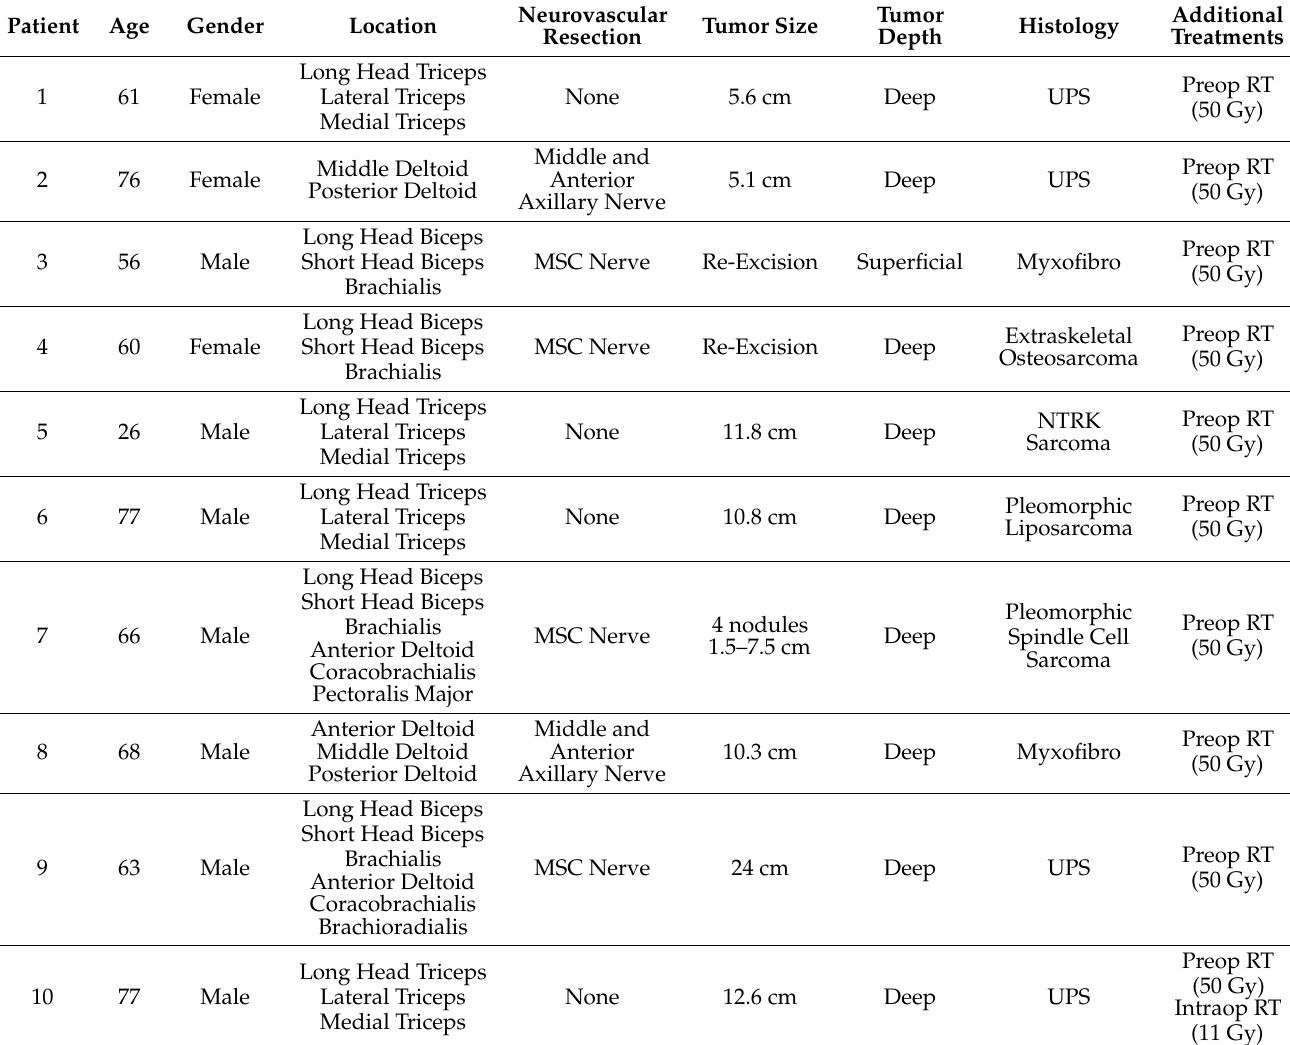
Table 1. Patients undergoing functional pedicled latissimus flap